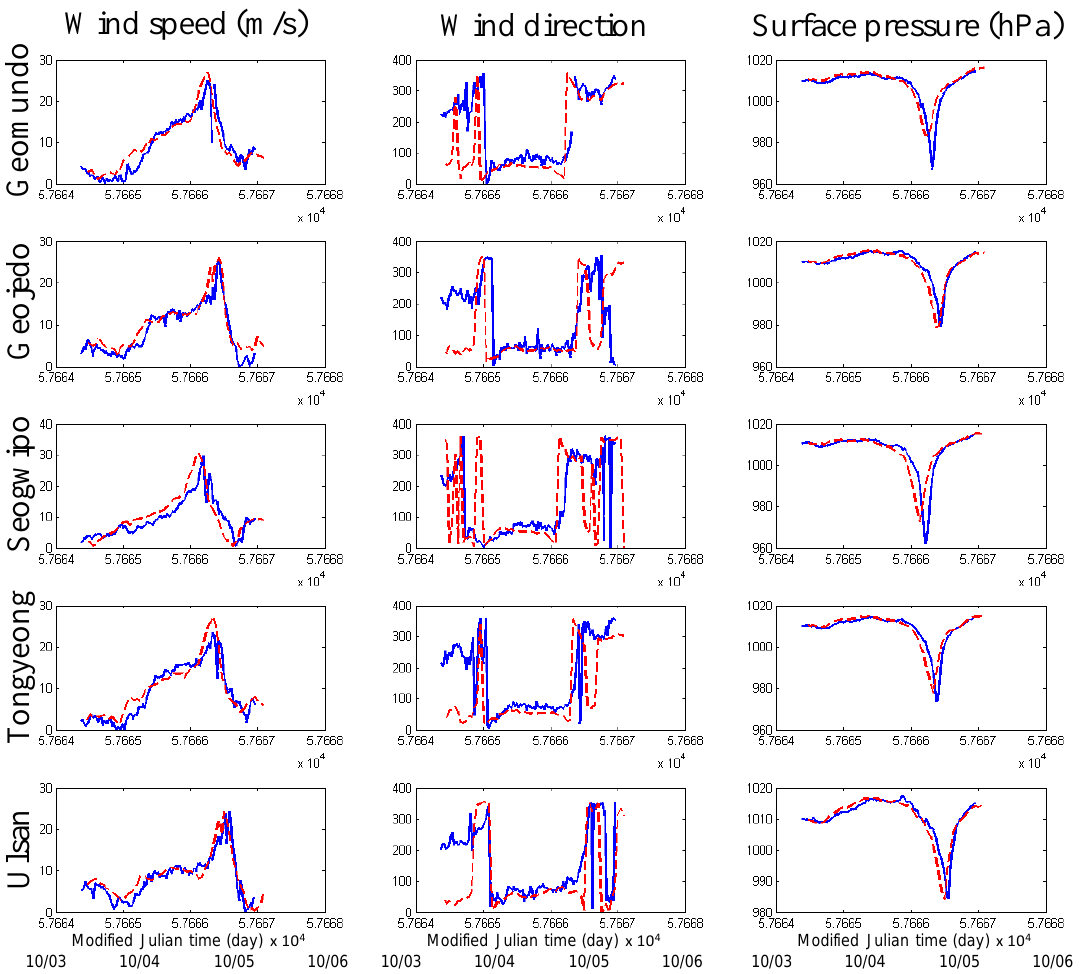
Figure 5. Verification of typhoon modeling by WRF (solid blue lines and dashed red lines denote the observed and simulated results, respectively).